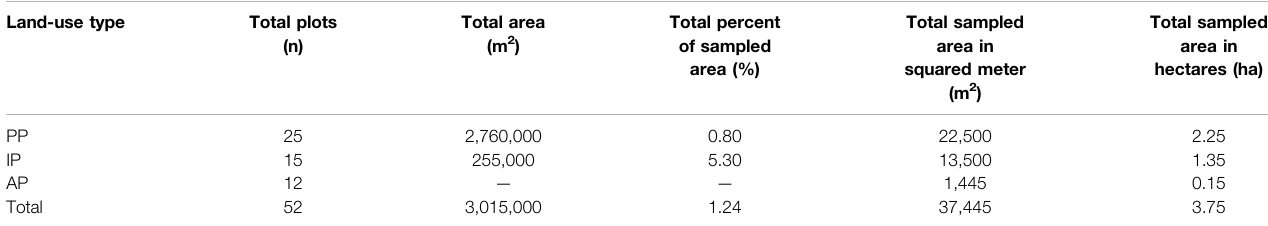
TABLE 2 | Field data and land-use types. Land-use